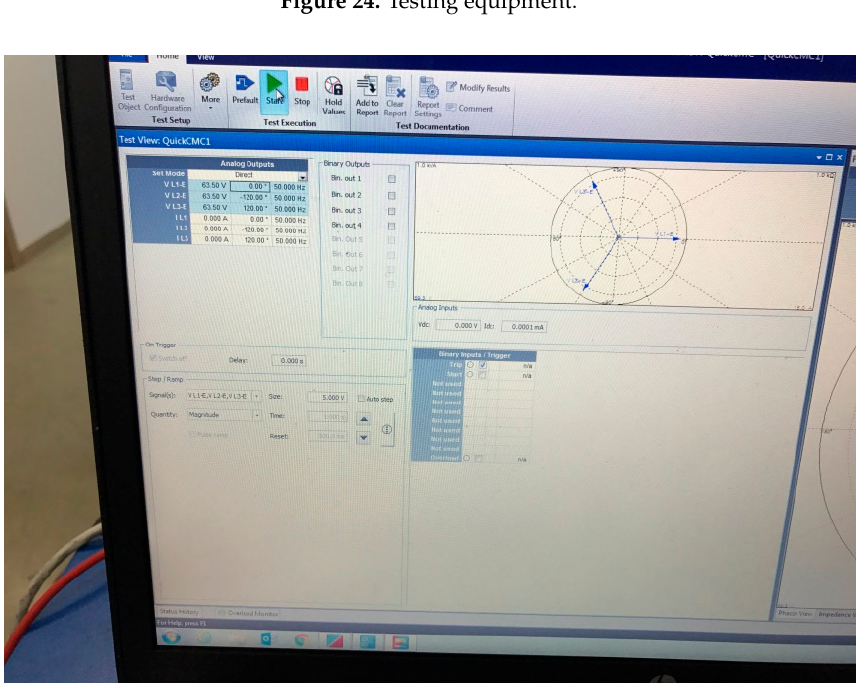
Figure 25. Entering voltage and frequency. Table 6. The specifications of a diesel combustion power station in Papua New Guinea.